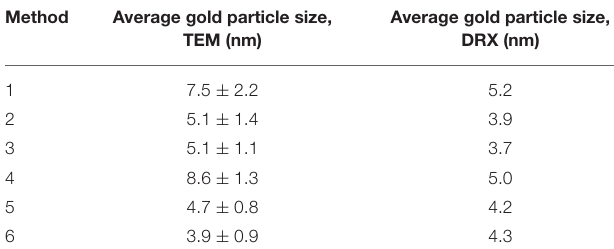
TABLE 6 | Average gold particle size of the Au/C catalyst obtained with different calcination methods. Method